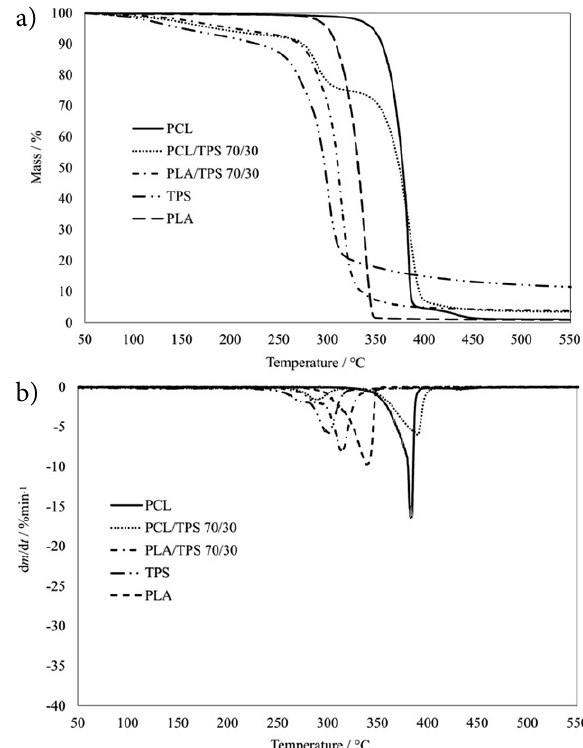
Fig. 2. TG (a) and DTG (b) curves of the thermal degradation of the PCL/TPS and PLA/TPS blends at the heating rate of 2.5 °C min −1